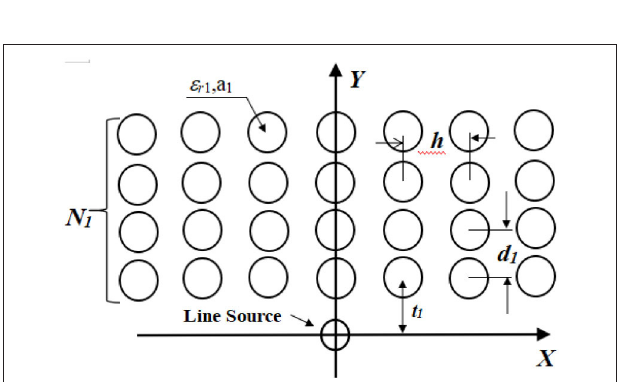
FIGURE 1 | The structural representation of the microstrip antenna. (A) The geometry of the proposed antenna, (B) The structure of the patch, (C) The cross-section view of the coaxial feed.